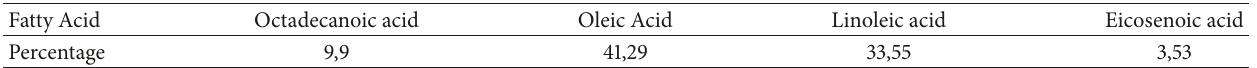
Table 2: Fatty acid composition of Jatropha curcas oil.